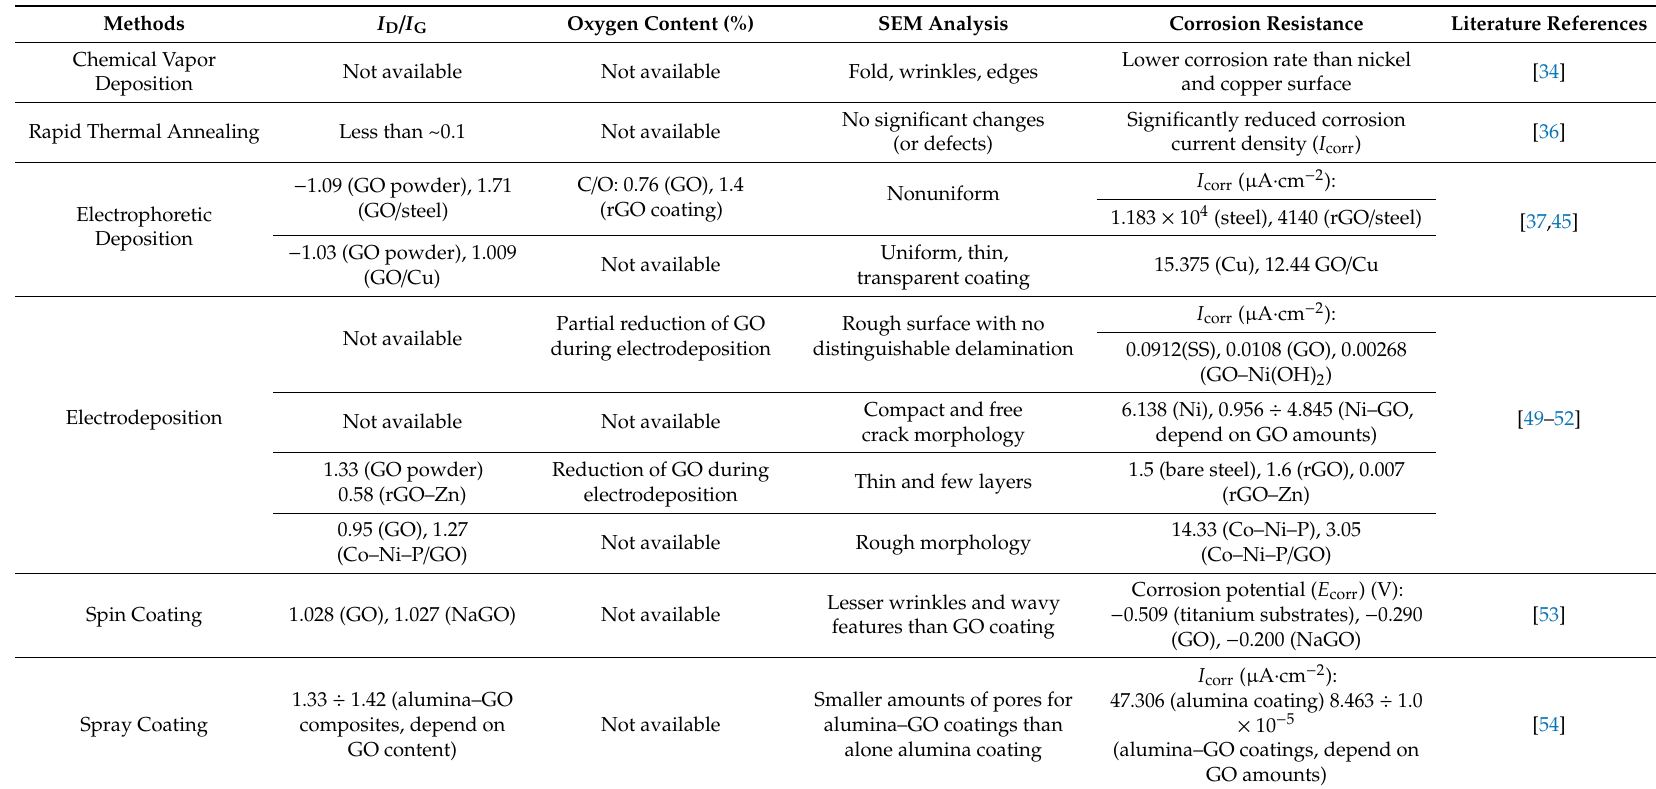
Table 3. Overview of numerous factors and their impact on the corrosion